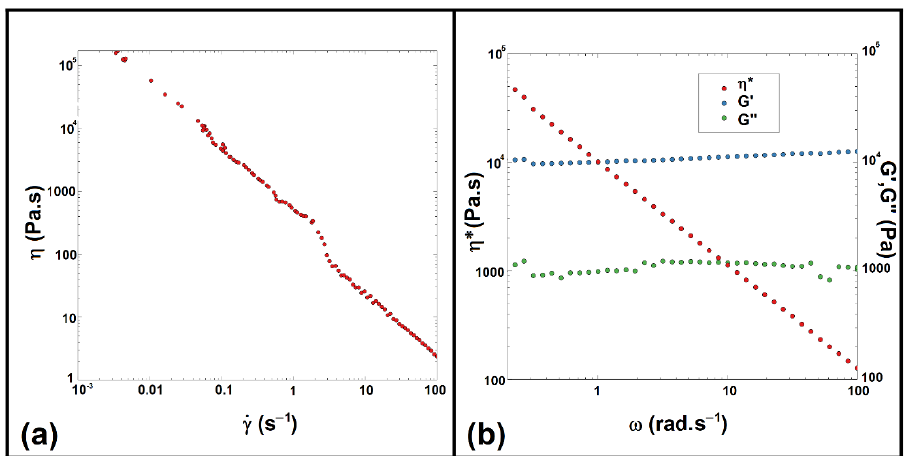
Figure 7. Rheological properties of xyl-TCPP-3: viscosity (h) of xyl-TCPP-3 as a function of shear rate ( a ) , storage modulus (G′) , and loss modulus (G″) of xyl -TCPP-3 as a function of angular fre- quency ( b ).